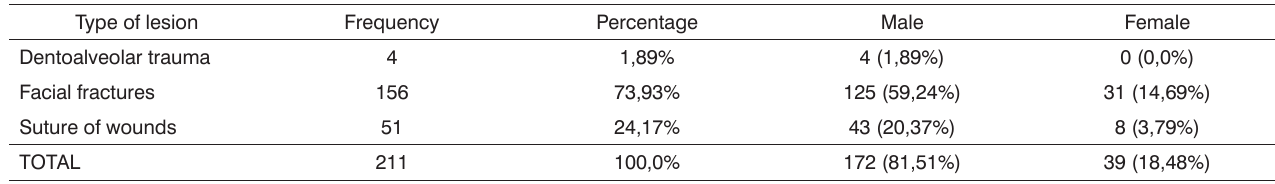
Table 5. Distribution and frequency of the population per type of lesion and